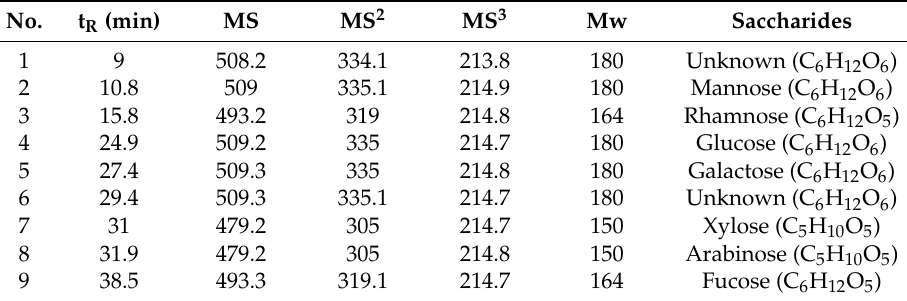
Table 1. Identification of monosaccharide composition of FPS.